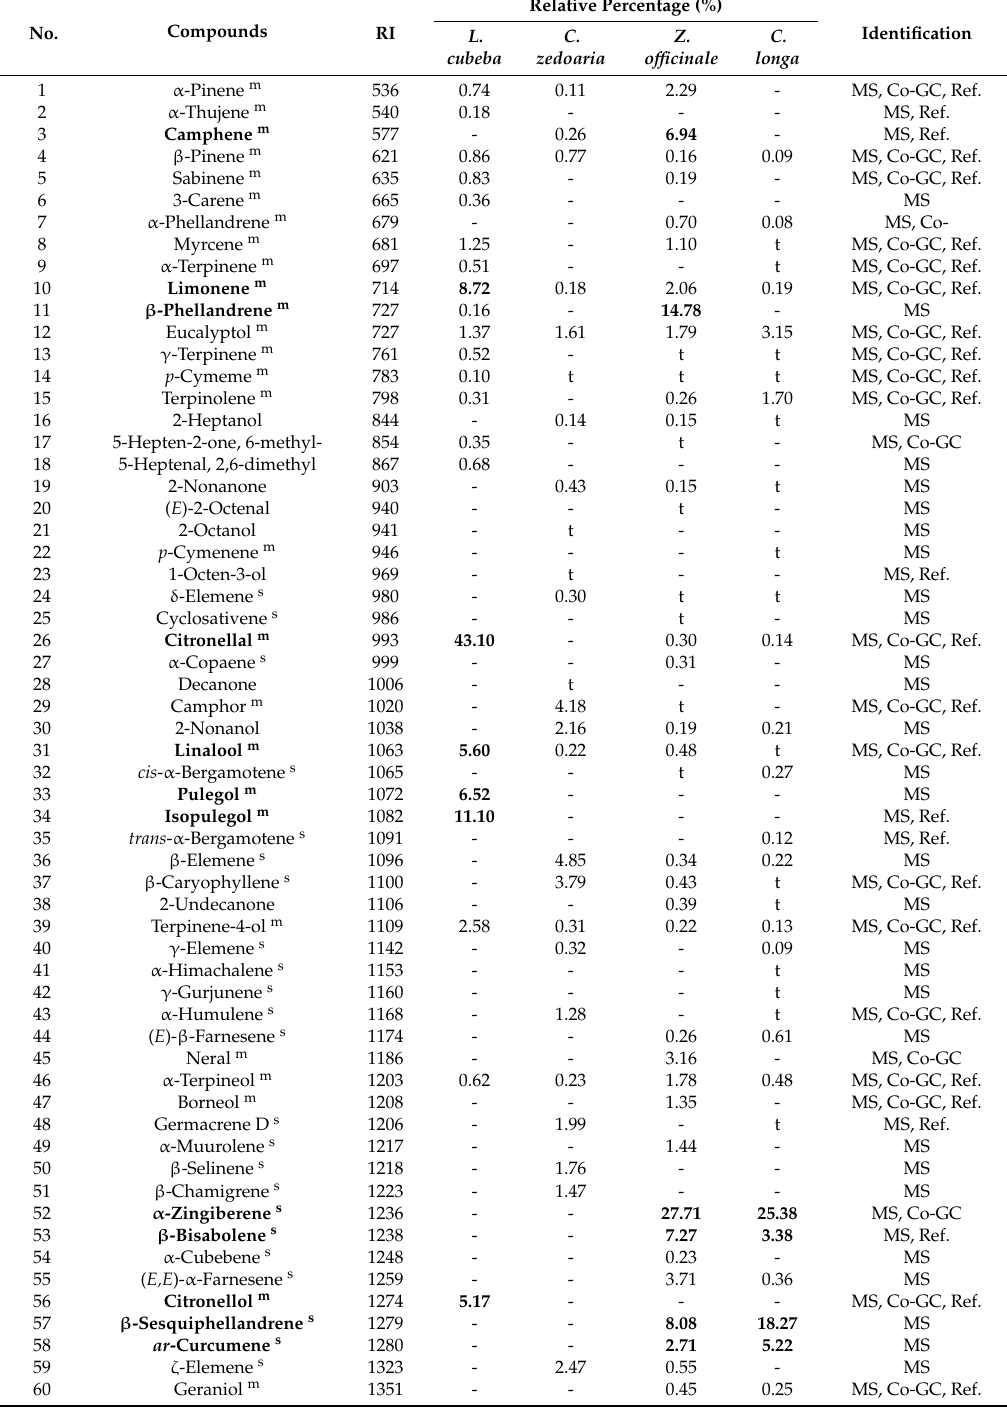
Table 2. Chemical composition of the four selected